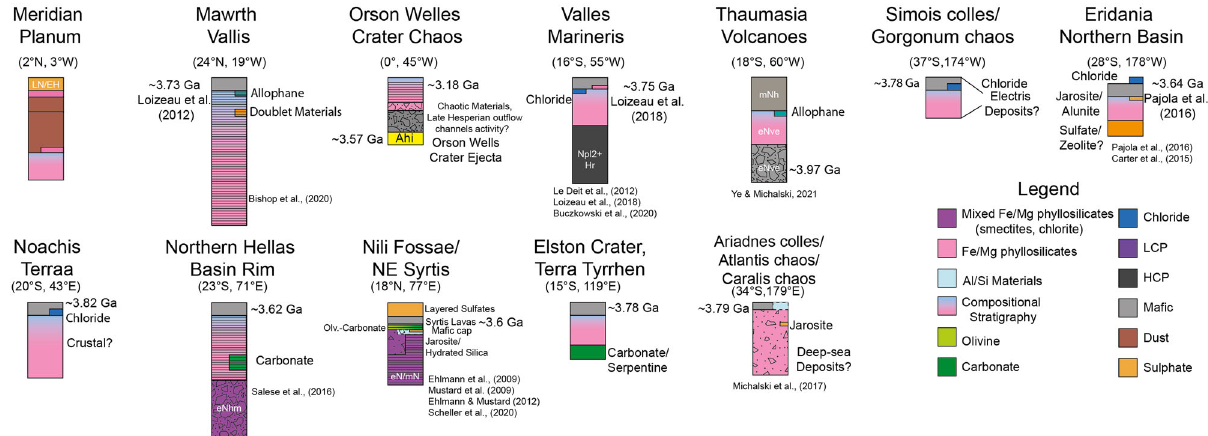
Fig. 7 Regional stratigraphy of compositional sequences on Mars. Updated regional stratigraphies from different locations on the planet – Nili Fossae/ northeastern Syrtis 22,27,40 , Valles Marineris 28,29,37,39 , Mawrth Vallis 18 – 21,23,24,32,33,38 , Terra Meridiani, Northern Hellas Planitia 35 , Western Terra Tyrrhen, Noachis Terra, Terra Sirenum, Orson Welles crater, Eridania northern basin 14,34 , Simois colles/Gorgonum chaos, and Ariadnes colles/Atlantis chaos/ Caralis chaos 36 (latitudes and longitudes as shown). The ordering of stratigraphic columns are arranged based on longitudes. This fi gure is purely schematic to show the complexity of weathering processes on Mars; individual sections and units are not to scale. The blue tone unit refers to Al-rich materials and the warm brown color indicates the occurrence of Fe/Mg-rich smectites. The age of speci fi c geologic units is